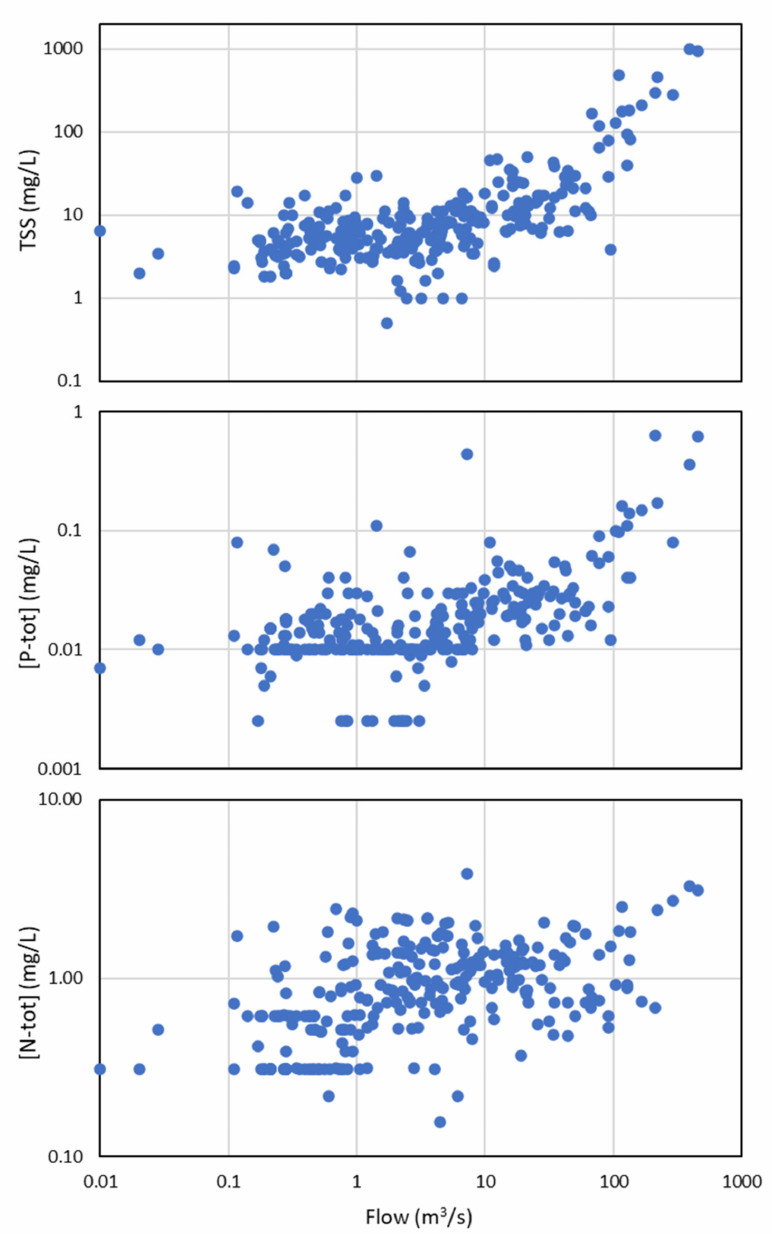
Figure 4. Examples of the concentration/flow relationships observed for the suspended solids, the total phosphorus and the total nitrogen in the Vidourle